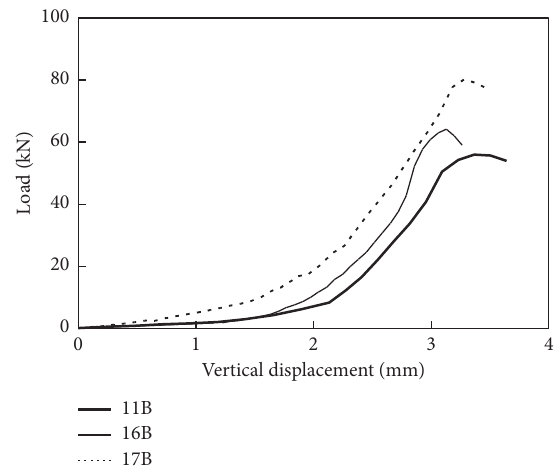
Figure 12: Load–displacement curves for the plastered straw bales laid